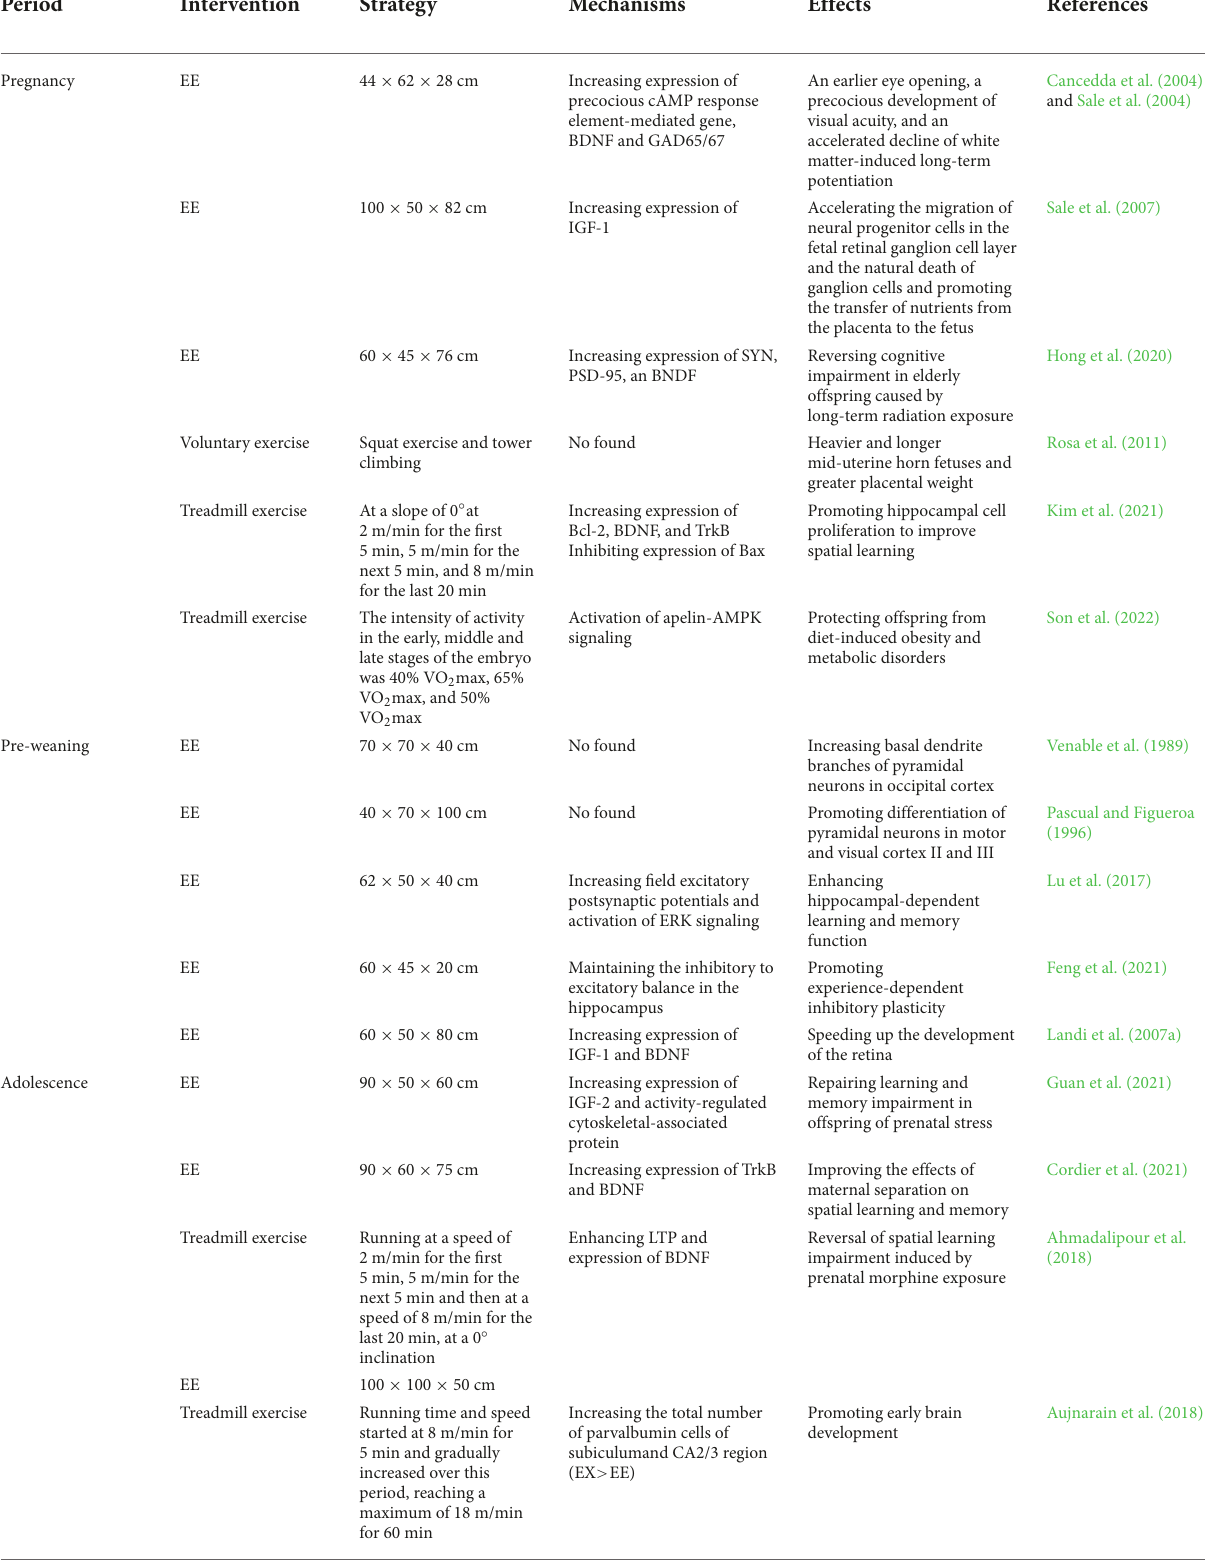
TABLE 1 Effects of physical activity and EE on brain